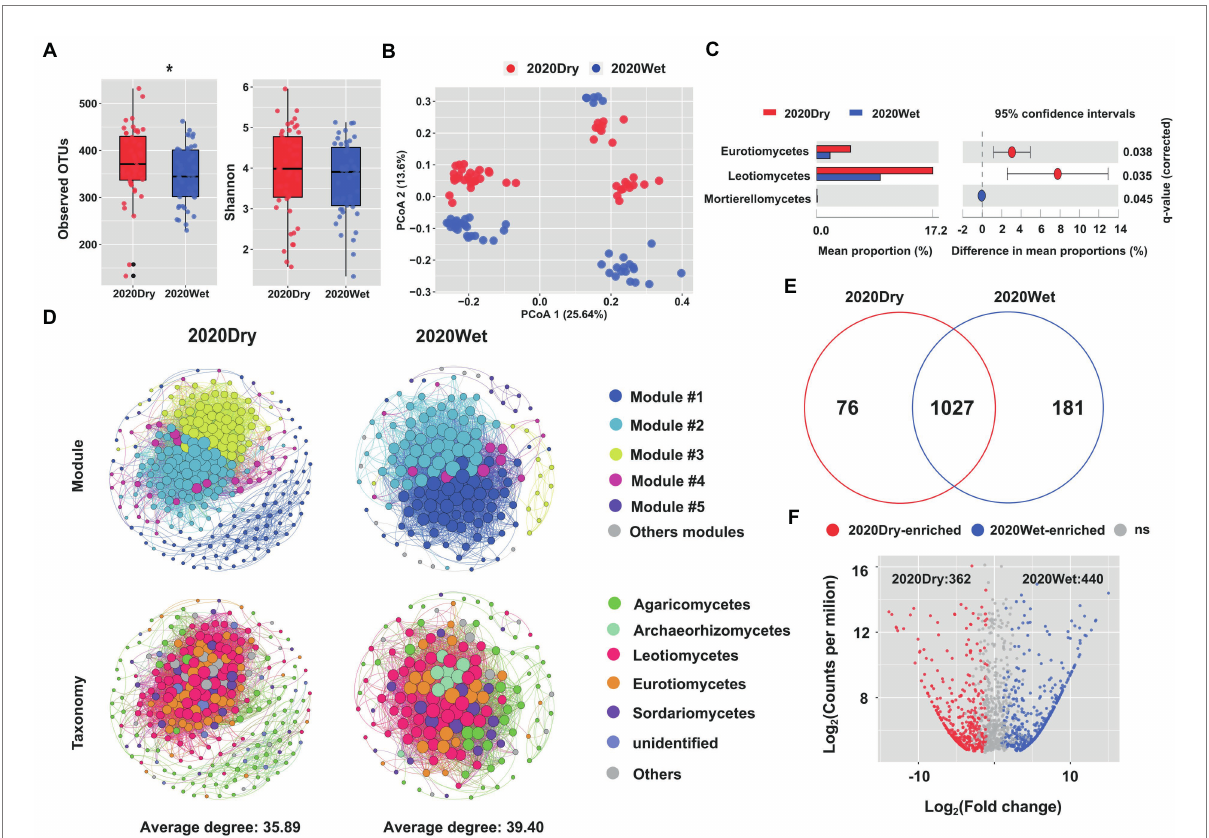
FIGURE 4 Seasonality influences the fungal microbiome of ECM roots. (A) Alpha-diversity measurements are based on the observed OTUs and Shannon index for the fungal OTUs. Statistical data analyses were performed using one-way ANOVA (* p < 0.05). (B) PCoA of beta-diversity using Bray-Curtis distances for fungal OTUs. (C) Differential abundances of fungal OTUs in ECM roots at the end of the dry season (2020Dry) and at the end of the wet season (2020Wet). Welch’s tests followed by Benjamini-Hochberg FDR corrections were performed for different sampling seasons. (D) Co- occurrence networks in fungal communities at the end of the dry season (2020Dry) and at the end of the wet season (2020Wet). (E) Venn diagrams showing the shared and specific fungal OTUs identified at the end of the dry season (2020Dry) and at the end of the wet season (2020Wet). (F) The Volcano plot displays the enriched OTUs for each sampling season. Each dot represents a single out, while red and blue dots represent an individual enriched OTUs identified at the end of the dry season (2020Dry) and at the end of the wet season (2020Wet),